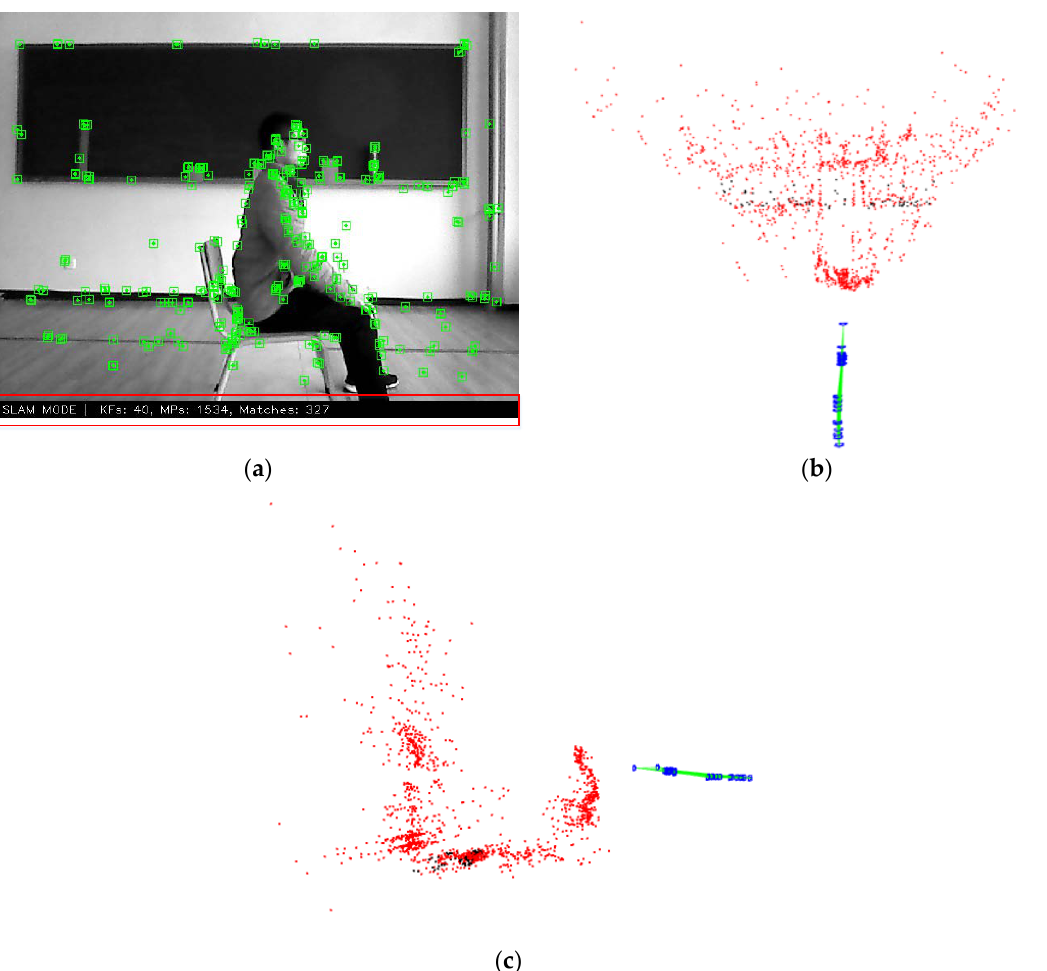
Figure 11. The map status after restore mapping. ( a ) Current RGB frame after restore mapping; ( b ) vertical-view angle of the map; ( c ) side-view angle of the map.